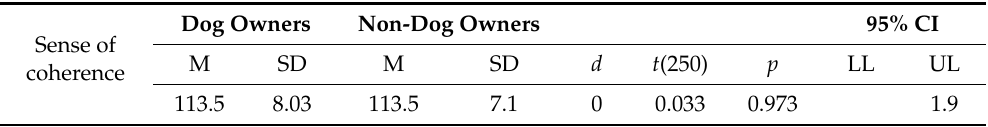
Table 1. Mean di ff erences of the groups “dog owners” and “non-dog owners” regarding the strength of the sense of coherence.